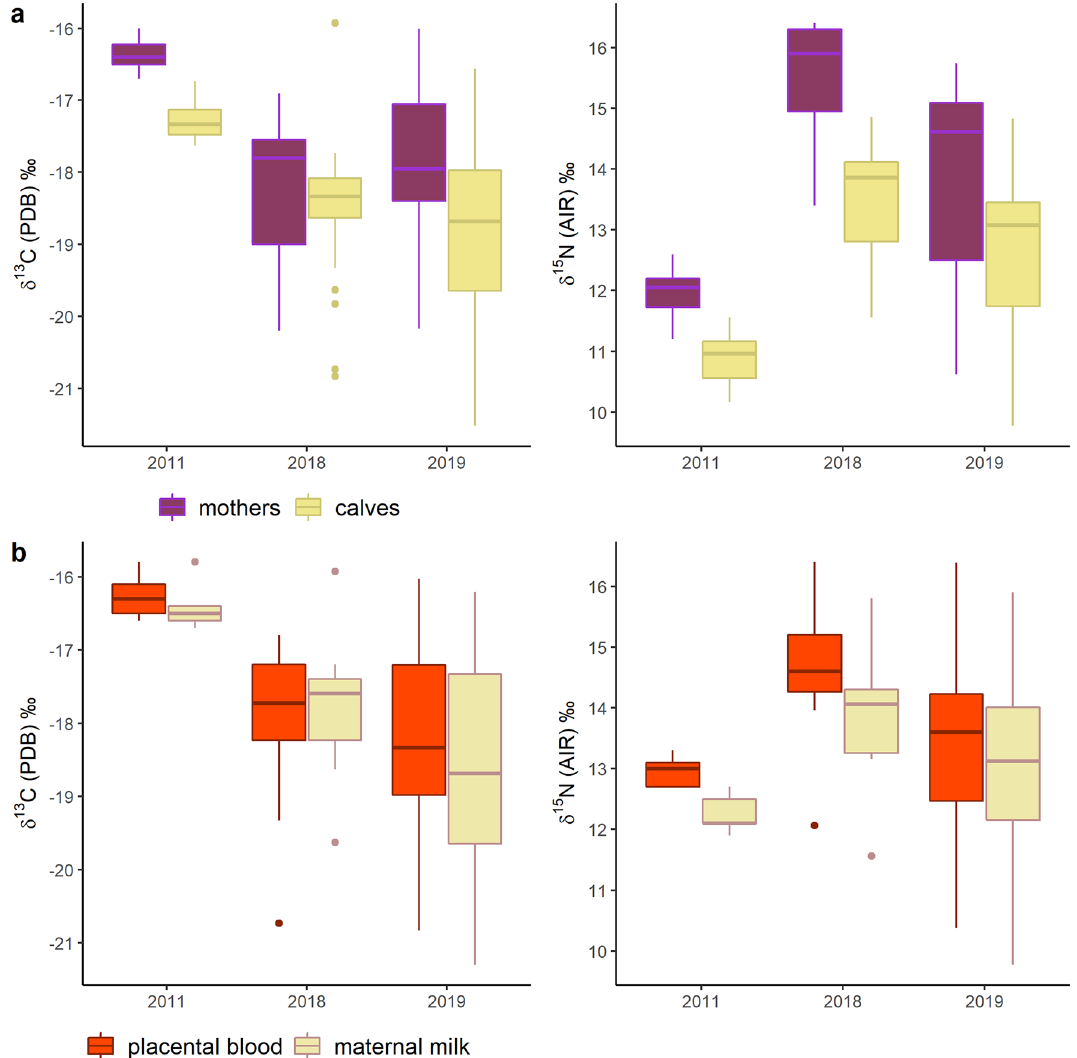
Figure 2. Boxplots of the mean δ 13 C and δ 15 N values of gray whale mothers and calves’ epidermis collected in 2011, 2018 and 2019 ( a ), and mean estimated δ 13 C and δ 15 N values of placental blood and maternal milk ( b ) using Eq.